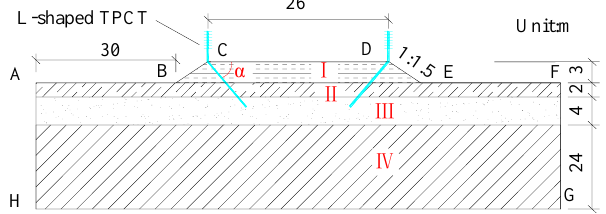
Figure 3. Calculation model of the subgrade with L-shaped TPCTs. Table 3. Thermophysical parameters of different soils.